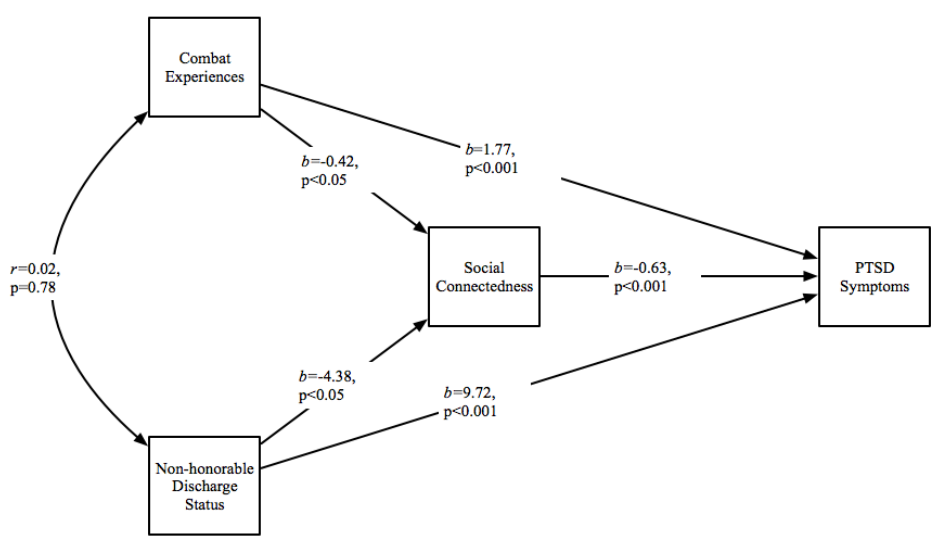
Figure 1. Path model with unstandardized direct effects.